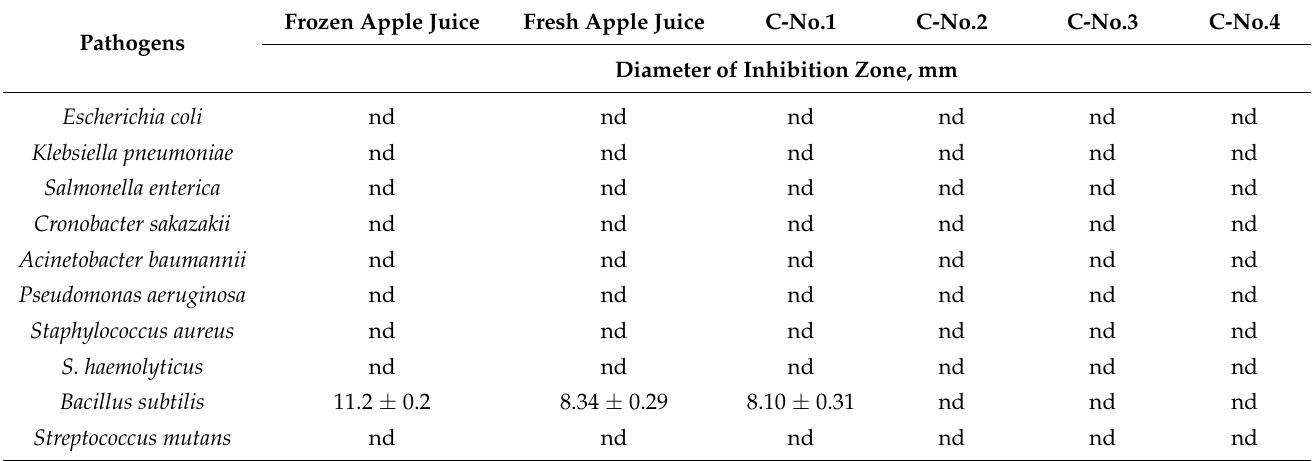
Table 4. Antimicrobial properties of apple juice and